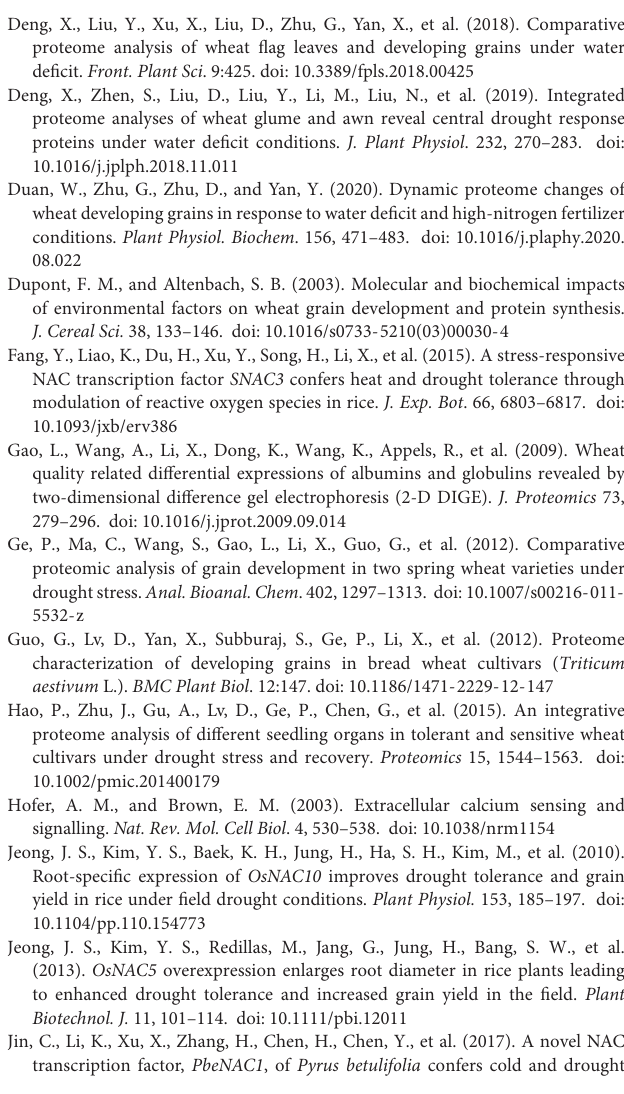
stages and abiotic stresses based on RNA-seq data. Supplementary Table 8 | Sequence of specific primers for qRT-PCR